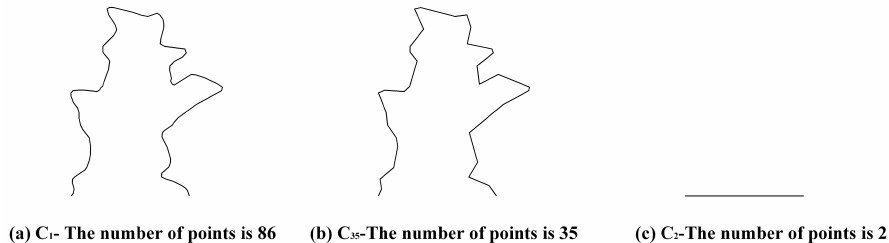
Figure 12. Different contours with different points. ( a ) The initial contour (C 1 ) with 86 points. ( b ) The simplified contour (C 35 ) with 35 points. ( c ) The simplified contour (C 2 ) with 2 points.